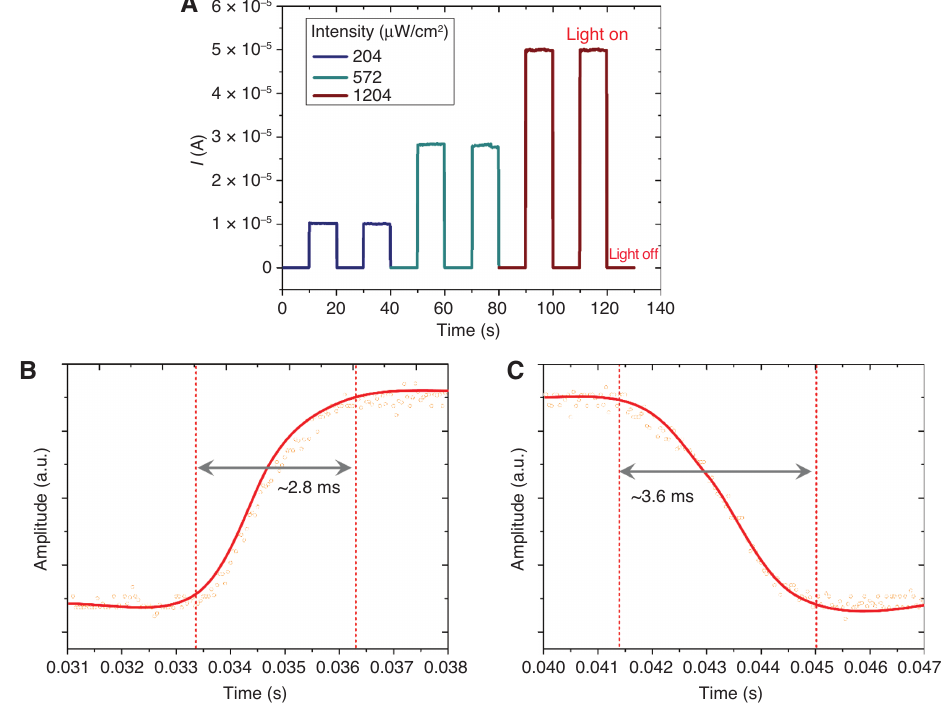
O /Si heterojunction photodetector. 2 3